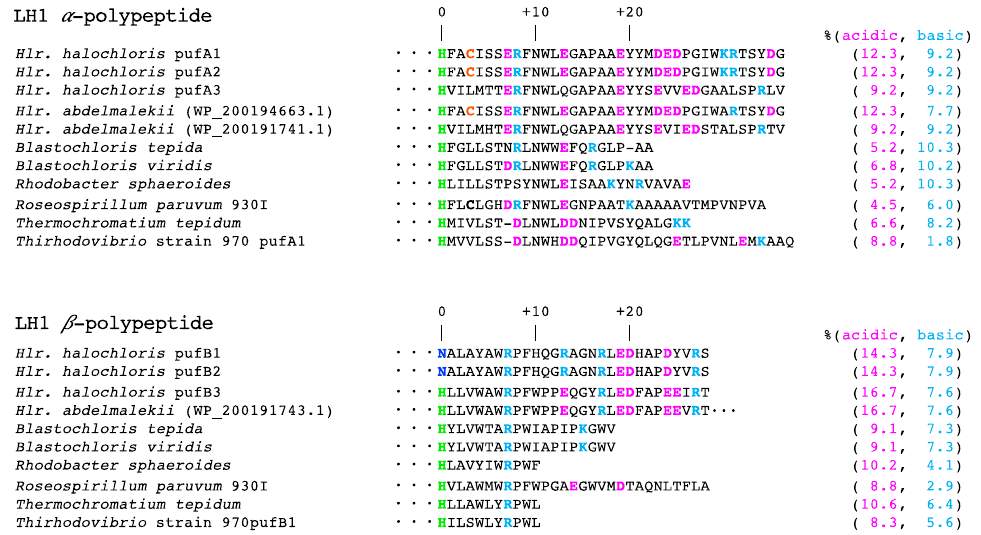
Figure 4. Amino acid sequences of the LH1 α - and β -polypeptides from several purple phototrophic bacteria. The sequences are aligned relative to the His residues (His 0 , green) coordinating BChl molecules. Acidic (Asp, Glu) and basic (Arg, Lys) residues are highlighted with magenta and cyan, respectively. Unique Cys residues in the vicinity of His 0 are colored with orange. The numbers of right side represent percentages of acidic and basic residues in each polypeptide.